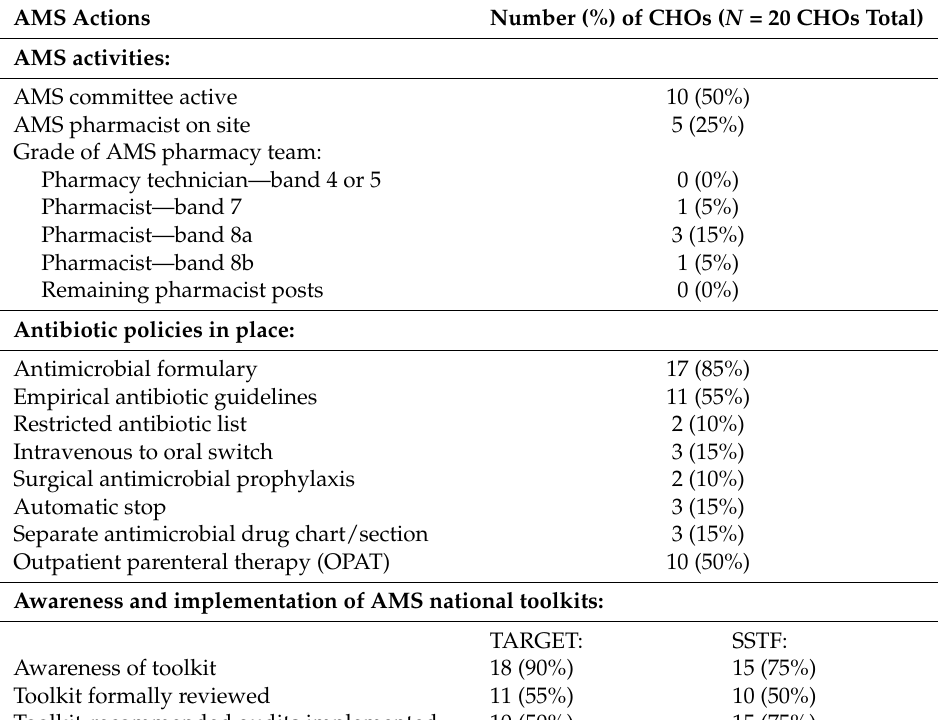
Table 1. Summary of antimicrobial stewardship activities and the implementation of national